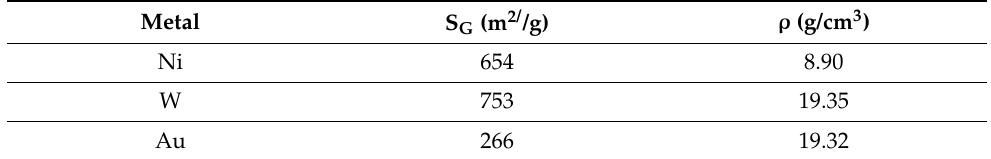
Table 5. Metal surfaces ( S G ) and densities of